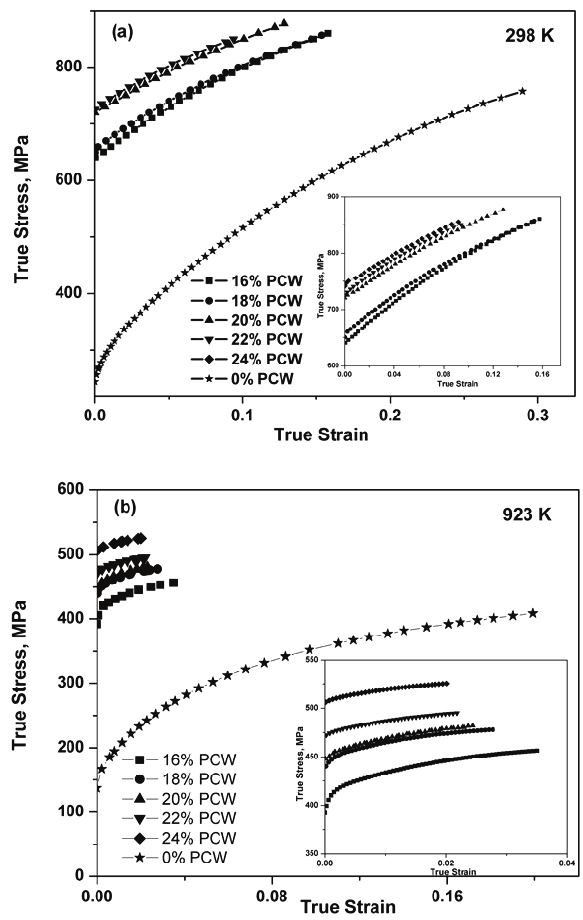
Figure 1. True stress-true strain curve of IFAC-1 with the insert showing the plot for PCW levels of 16%, 18%, 20%, 22% and 24% at (a) 298 K and (b) 923